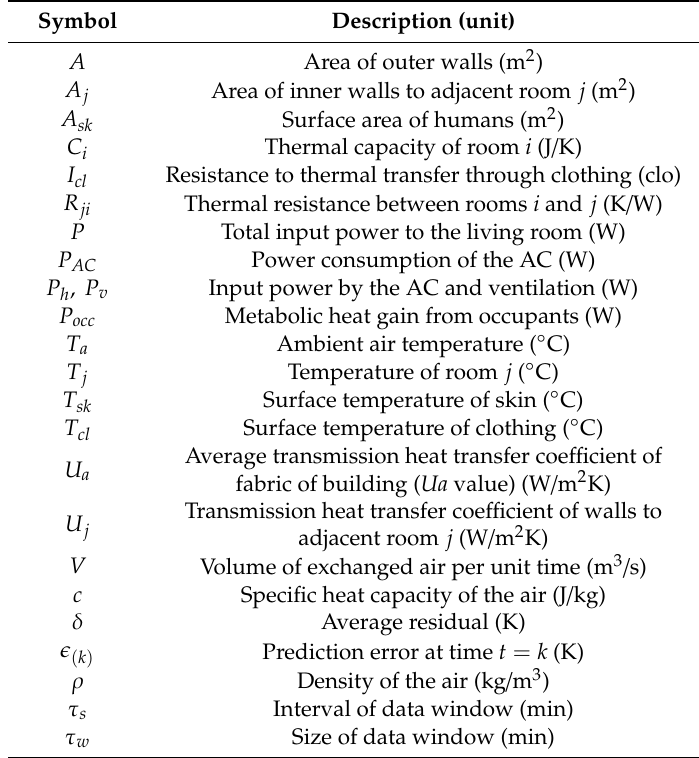
Table 1. Summary of